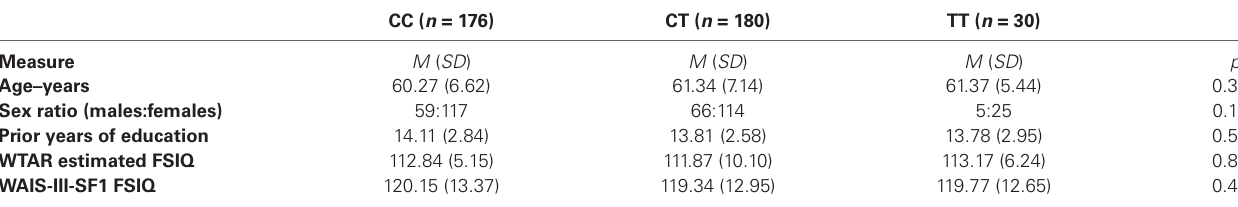
Table 1 | Difference between KIBRA genotype groups on demographic variables.